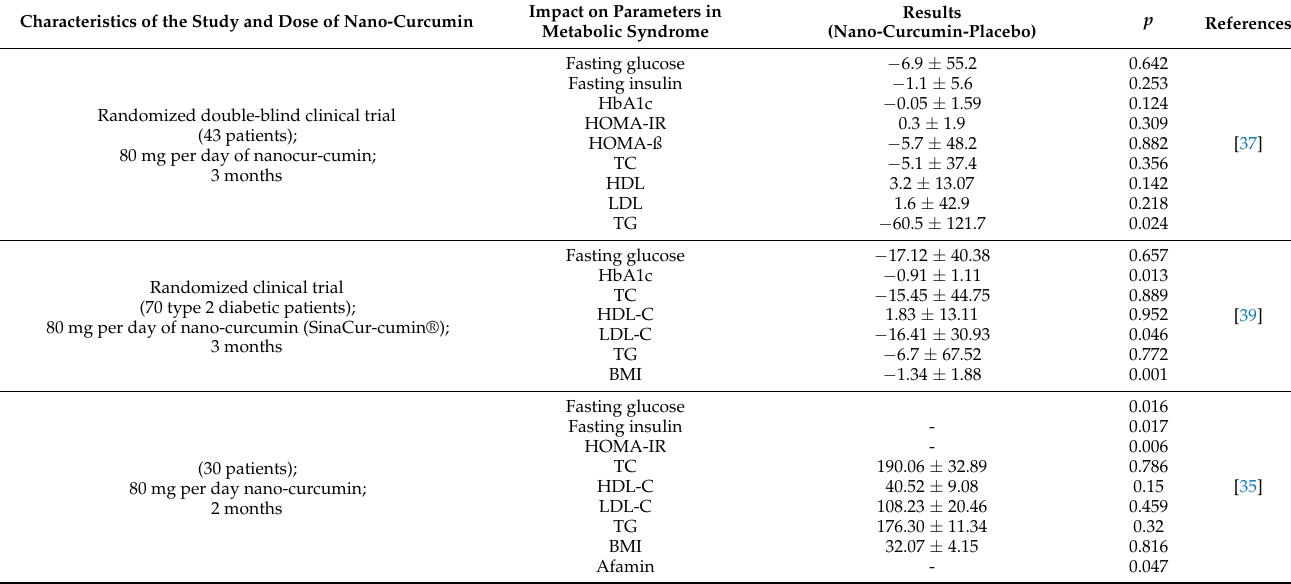
The results of supplementation nano-curcumin on metabolic parameters in metabolic syndrome and diabetes